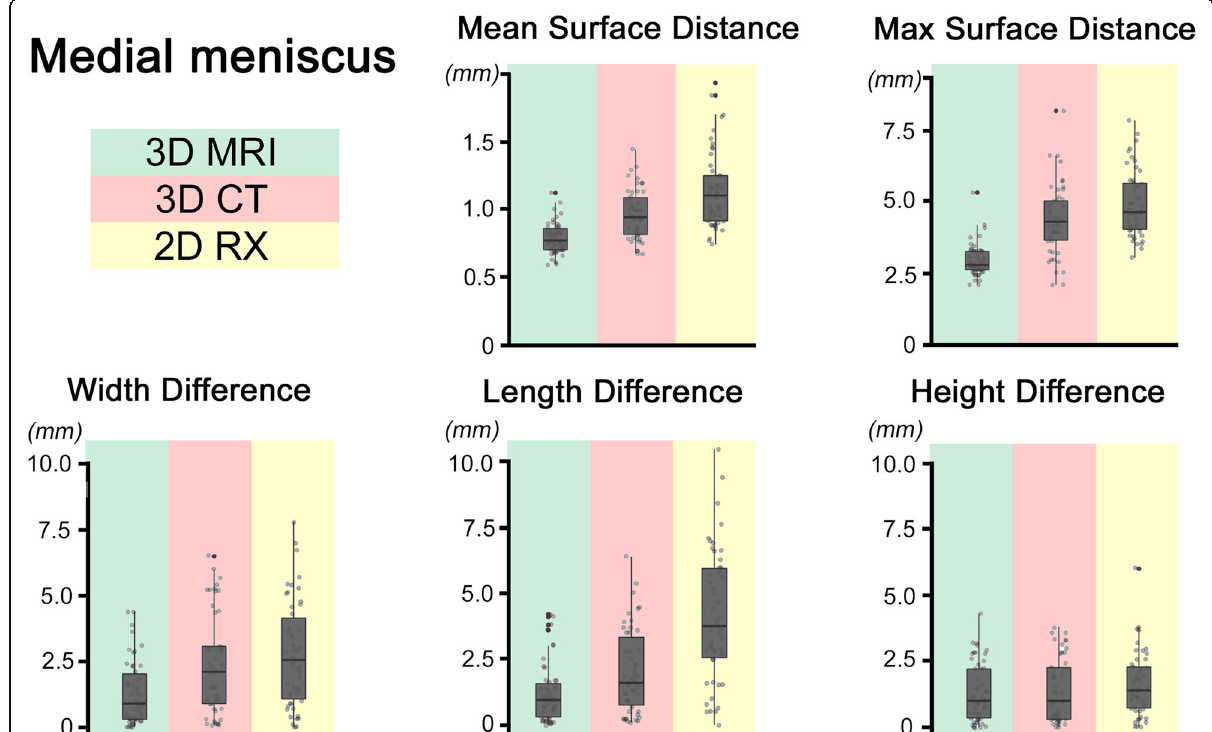
Fig. 5 Medial Meniscus. Boxplots for medial meniscus. The box represents the middle 50% of values. The box represents the middle 50% of values. The ends of the whiskers indicate 1.5 times the IQR (inter quartile range) between the lower and upper quartile, and outliers are denoted with a